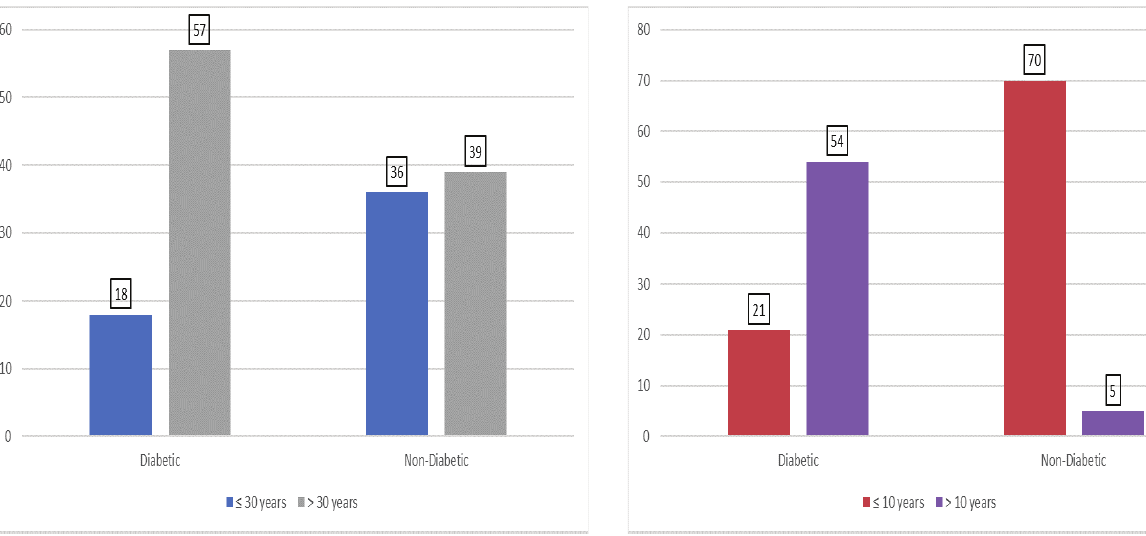
Figure–I: Patient's Ratio based on age (n=150). Figure–II: Ratio of patients according to hospital stay duration groups (N=150). Table-I: Comparison of general characteristics, blood and serum parameter of the study